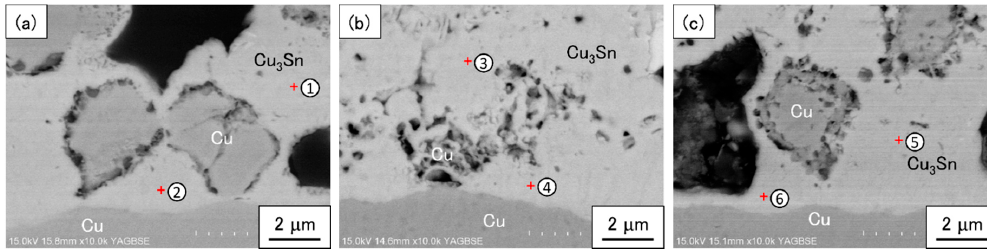
Figure 10. Cross-sectional SEM images of the interfaces between the bonding layer and substrate aged at ( a ) 150, ( b ) 175, and ( c ) 200 °C for 1000 h. Table 3. Chemical composition (at.%) in the marked areas in Figure 10 measured by EDX spectroscopy.